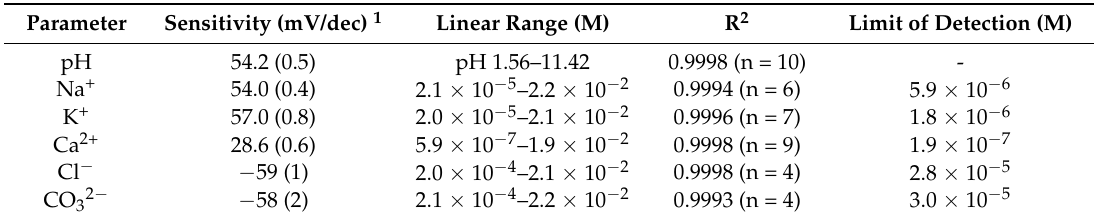
Table 2. Response characteristics obtained from the calibration curves for each type of ISFET using the multi-ISFET